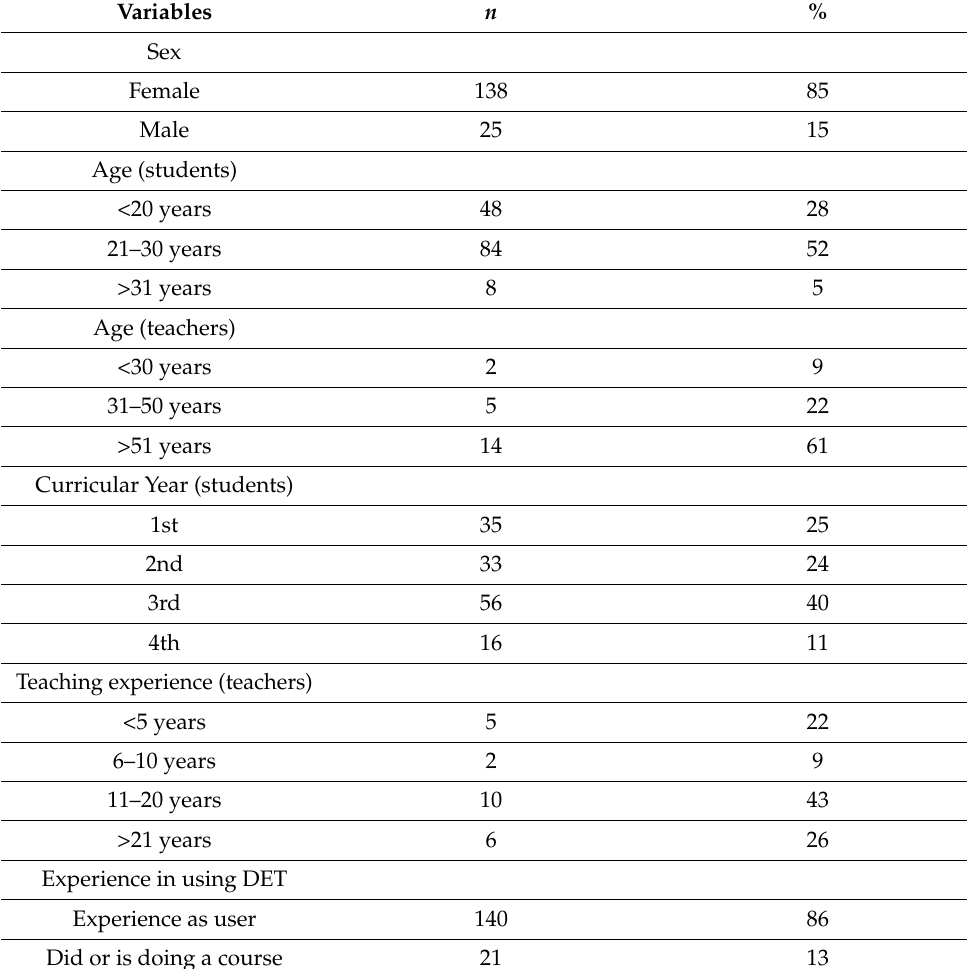
Table 2. Sample sociodemographic